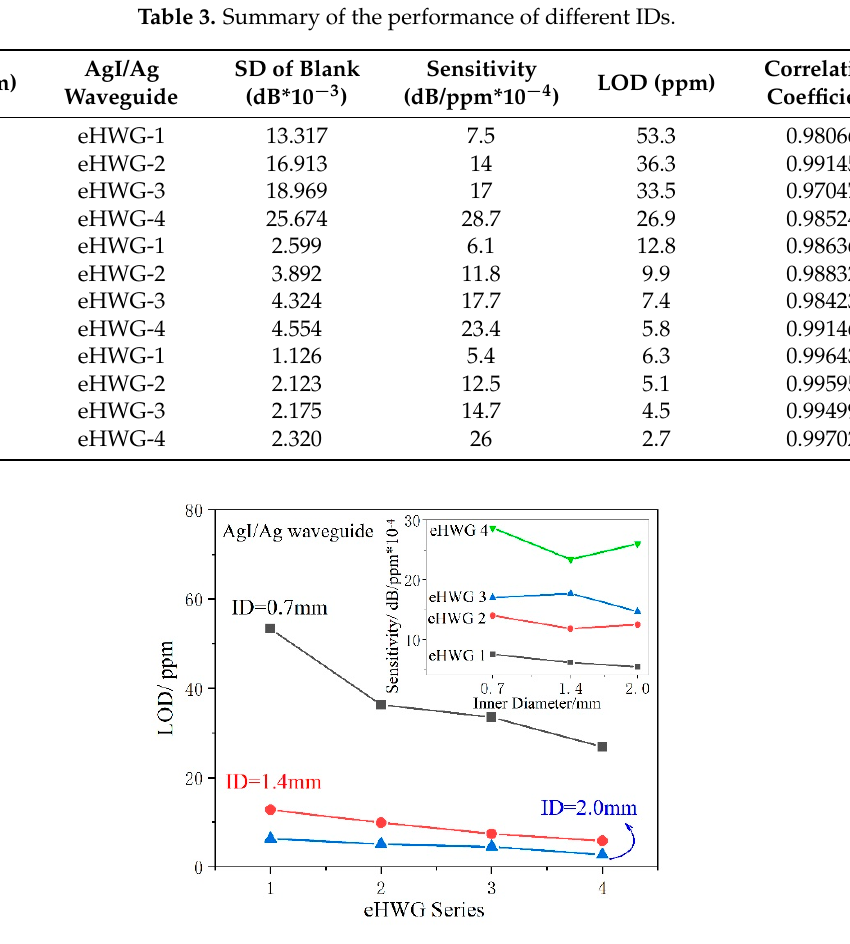
Figure 11. Characteristics of the eHWGs with AgI/Ag waveguides with different IDs.